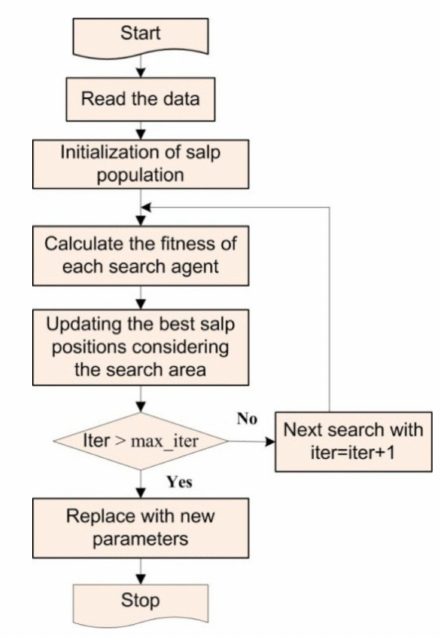
Figure 2. Flow diagram of the salp swarm algorithm (SSA).